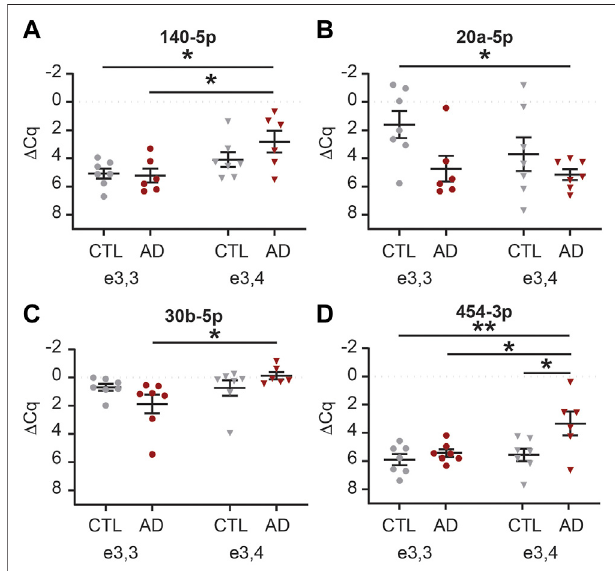
FIGURE10| MiRNAsaredifferentiallyexpressedbasedonAPOEstatus and disease state in male CSF EVs. Normalized Cq ( Δ Cq) values for four miRNAs that demonstrate a signi fi cant effect of APOE genotype on expression levels within AD and/or CTL male CSF EVs. (A) miR-140-5p was signi fi cantly increased in AD APOE-e3,4 vs. AD and CTL APOE-e3,3. (B) miR-20a-5p was signi fi cantly decreased in AD APOE-e3,4 vs. CTL APOE- e3,3. (C) miR-30b-5p was signi fi cantly increased in AD APOE-e3,4 vs. AD APOE-e3,3. (D) miR-454-3p was signi fi cantly increased in AD APOE-e3,4 vs. all other groups. Data shown as the mean ± SEM and analyzed by two-way ANOVA followed by Tukey ’ s multiple comparisons post hoc tests, * p < 0.05 and ** p <